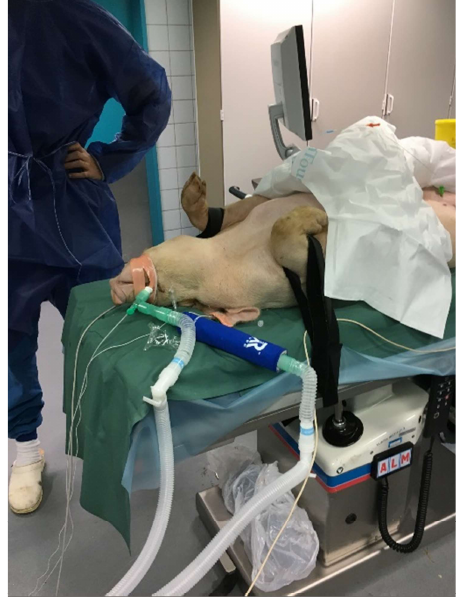
Figure 3. The Rtube was inserted between the expiratory limb of the Y-connector and the expiratory limb of the mechanical